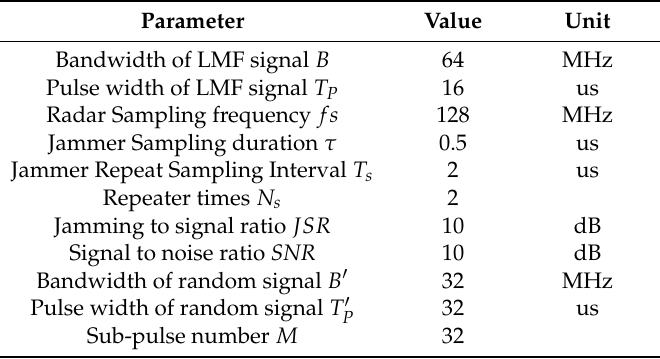
Table 1. Simulation